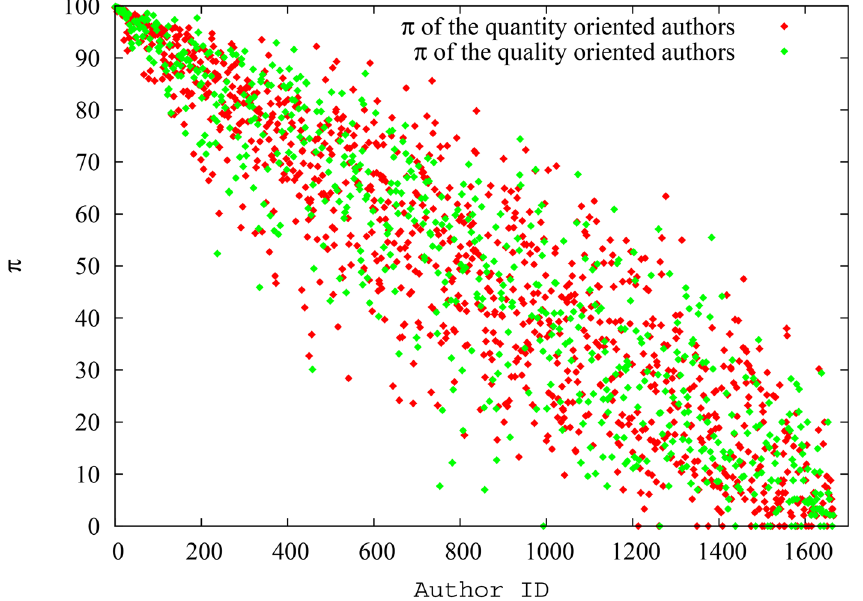
Fig 12. The spread of h-index for quantity oriented authors and quality oriented authors (as absolute values) in scenario 3. No group of authors have a clear advantage over the other group.